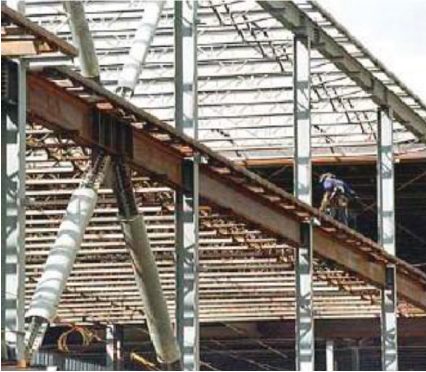
Figure 1: A BRB frame (a library in the